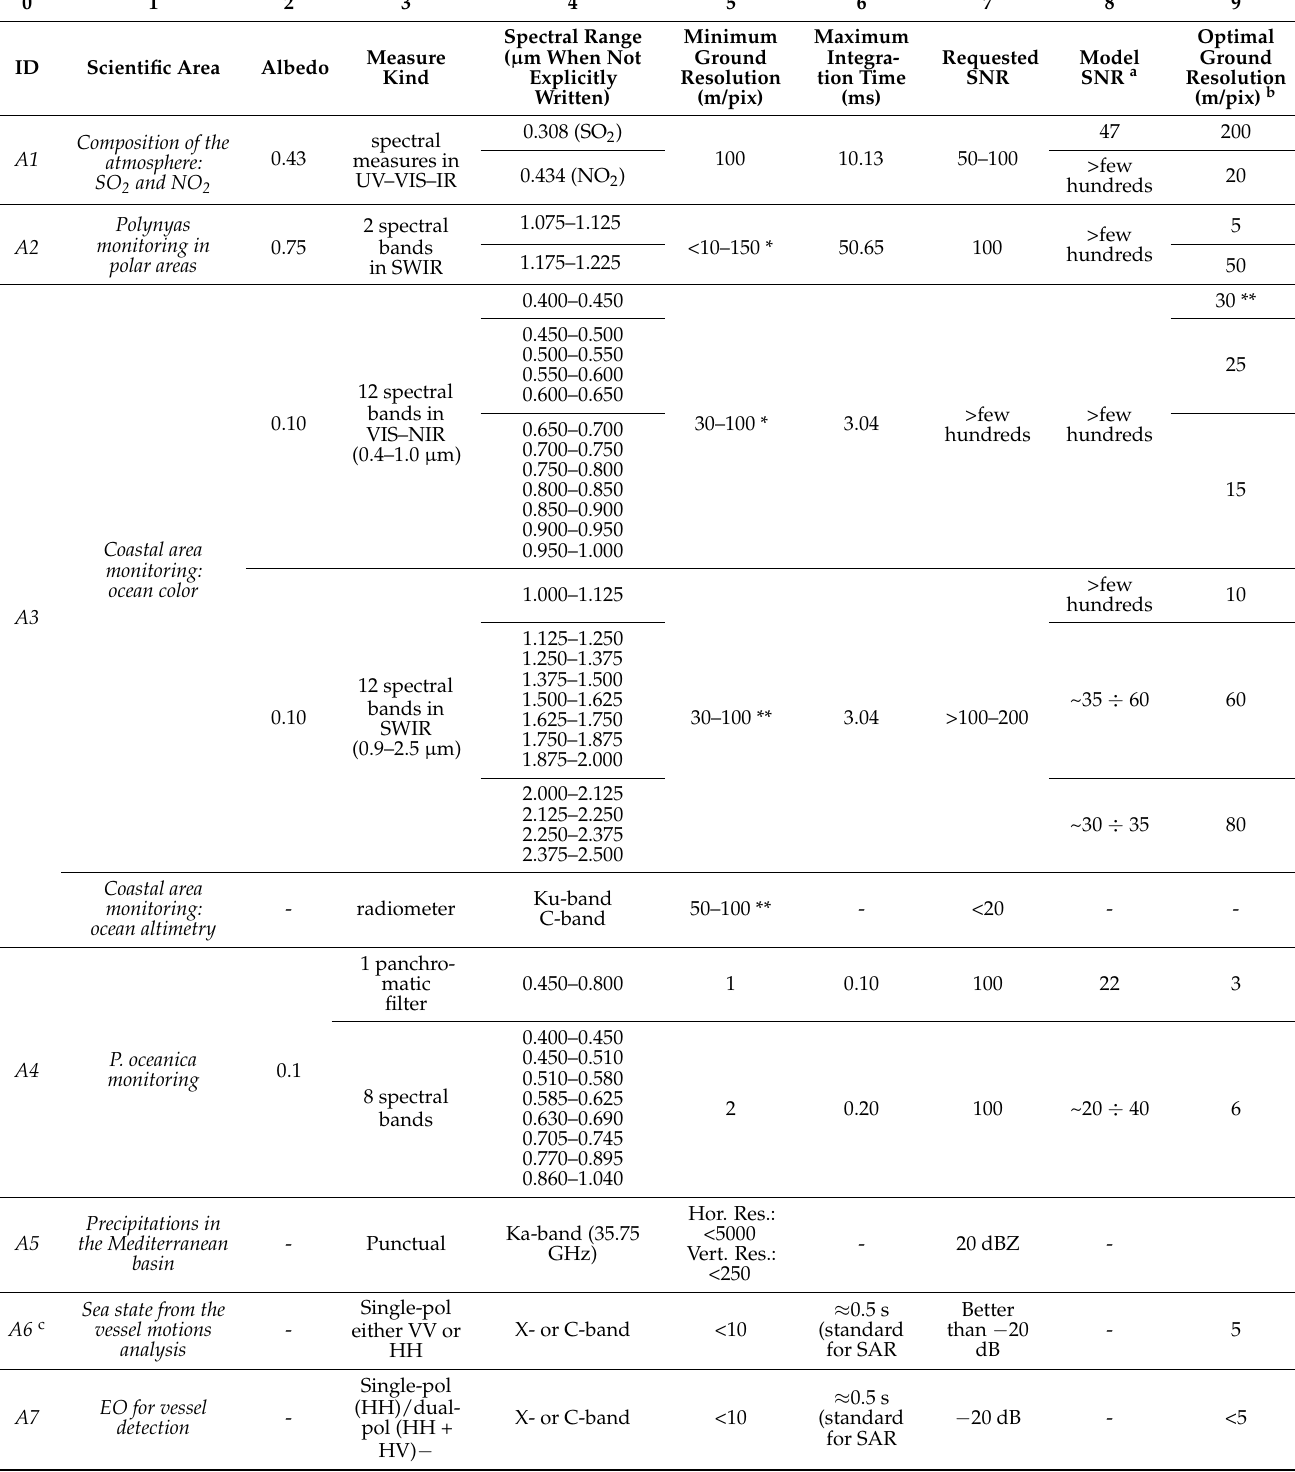
Table 4. Measurement requirements of the case studies presented in Section